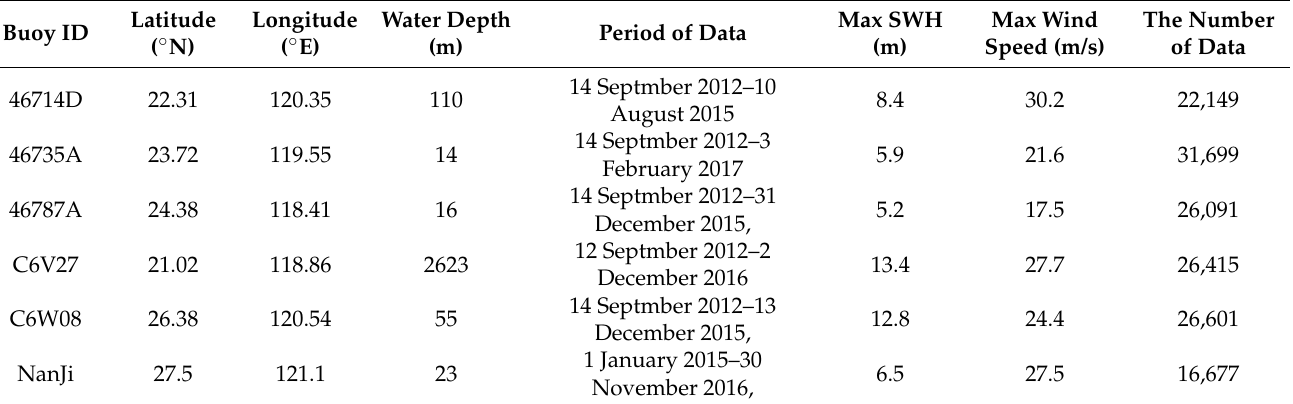
Table 1. Details of the selected